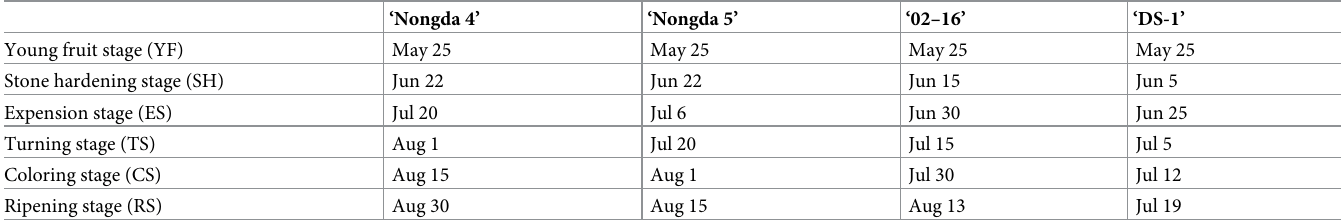
Table 1. Sampling date of Prunus humilis during fruit development stage in